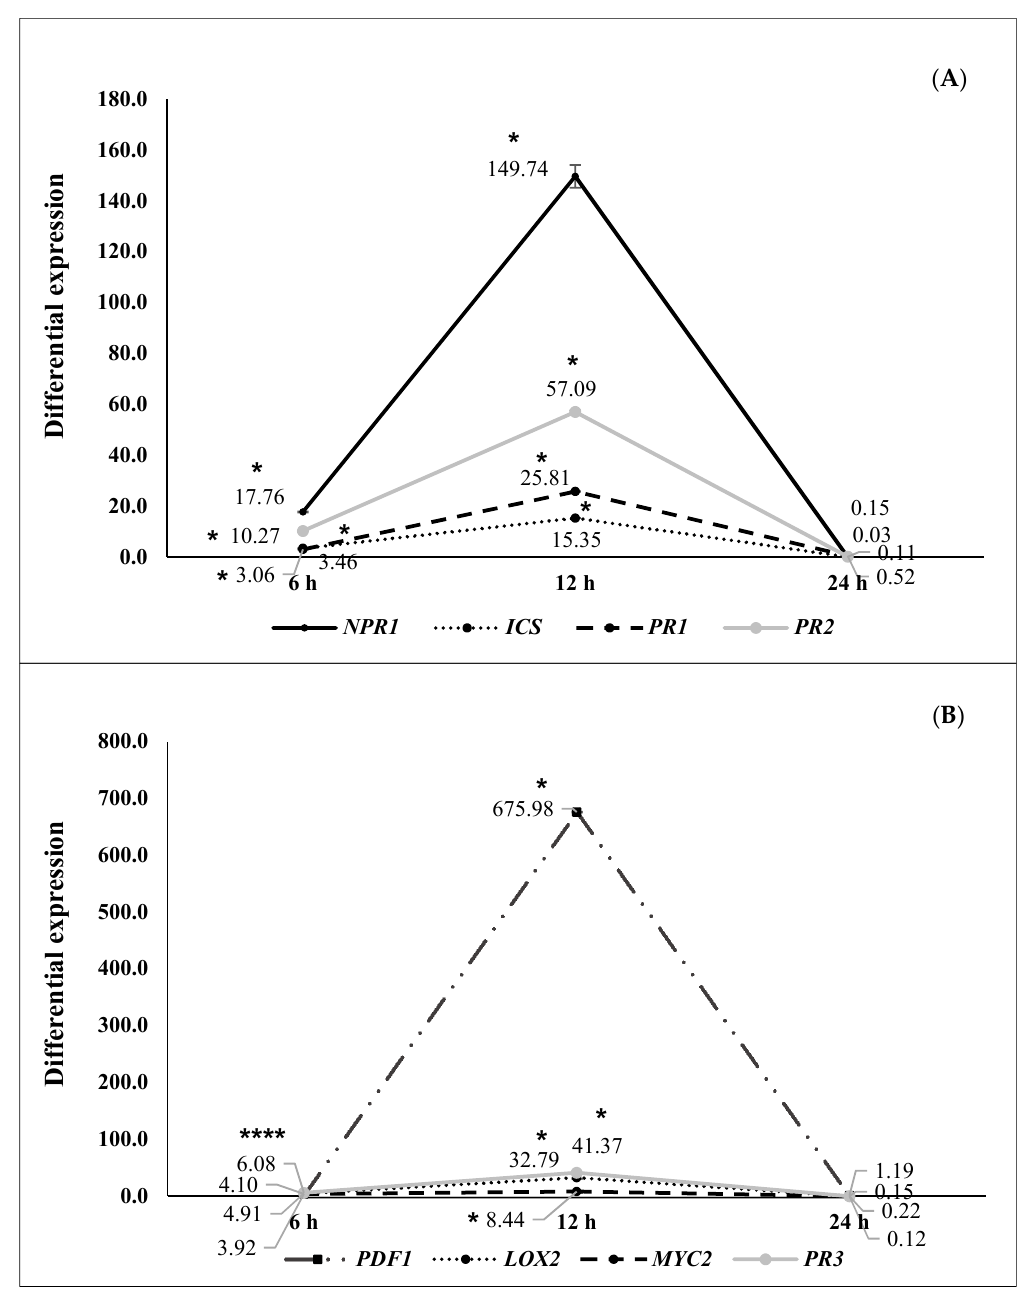
Figure 4. Differential gene expression (seedlings inoculated with N 12.34 ( Serratia rubidaea ) vs negative control) at 6 ( n = 16), 12 ( n = 16), and 24 ( n = 16) hapc; ( A ) NPR1 , ICS , PR1, and PR2 genes (as SA signaling pathway markers) and ( B ) PDF1 , LOX2 , MYC2, and PR3 (as JA/ET signaling pathway markers). Asterisks represent statistically significant differences ( p < 0.05) with respect to negative control (differential expression of 1).